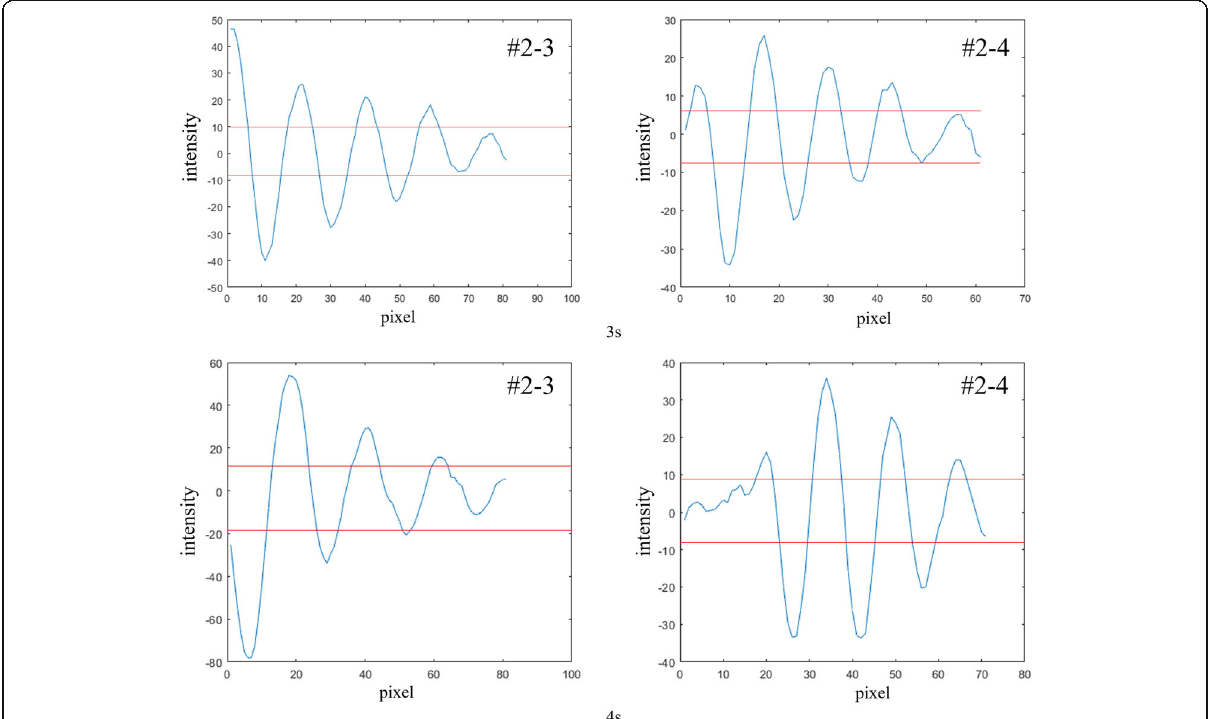
Fig. 13 Intensity distribution of oil films #3 and #4 at t = 3 s and 4 s for case with roughness